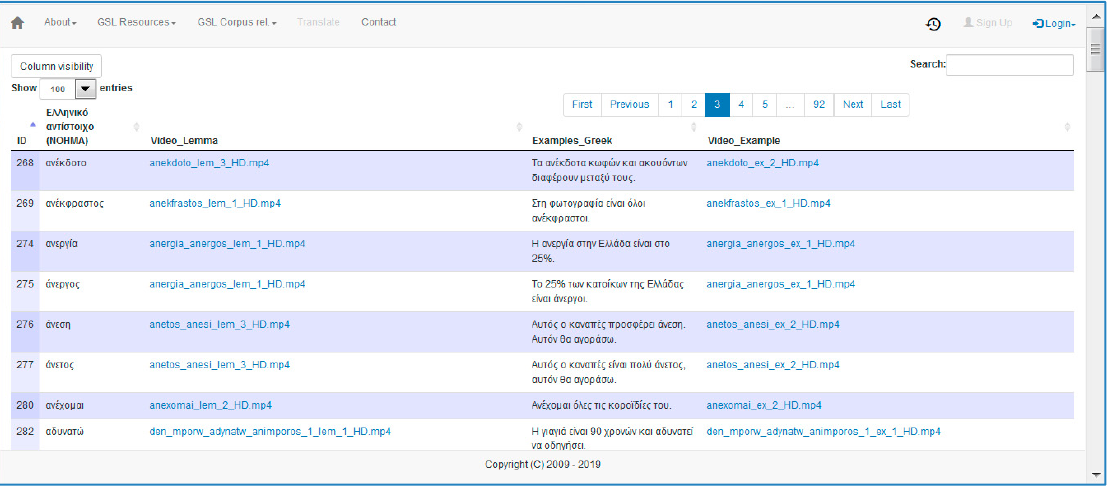
Figure 8. The SiS-Builder repository of signs.